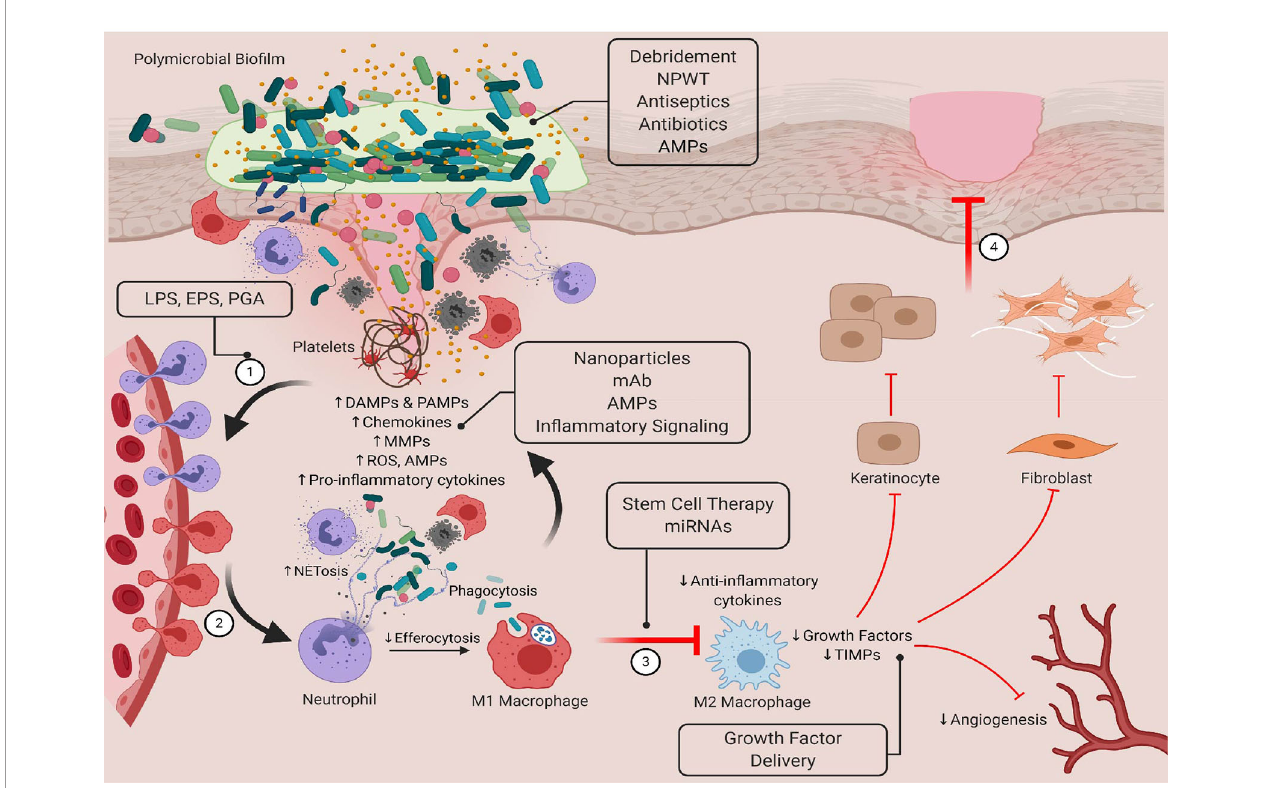
FIGURE 3 | Targeting bacteria-innate immune interactions to restore healing in chronic wounds. Standard therapies such as debridement, NPWT, antiseptics, and antibiotics have been shown to reduce bacterial bioburden in the wound bed, but they do not always restore healing processes. New therapeutics that have both antimicrobial and immunomodulatory properties may be able to overcome the limitations of more traditional treatments. Here, we show novel therapeutics that target these interactions that can be used in early and late stages of healing to restore tissue homeostasis. LPS, lipopolysaccharide; EPS, extracellular polymeric substance; PGA, peptidoglycan; AMP, antimicrobial peptide; mAb, monoclonal antibody; miRNA, microRNA. Created with